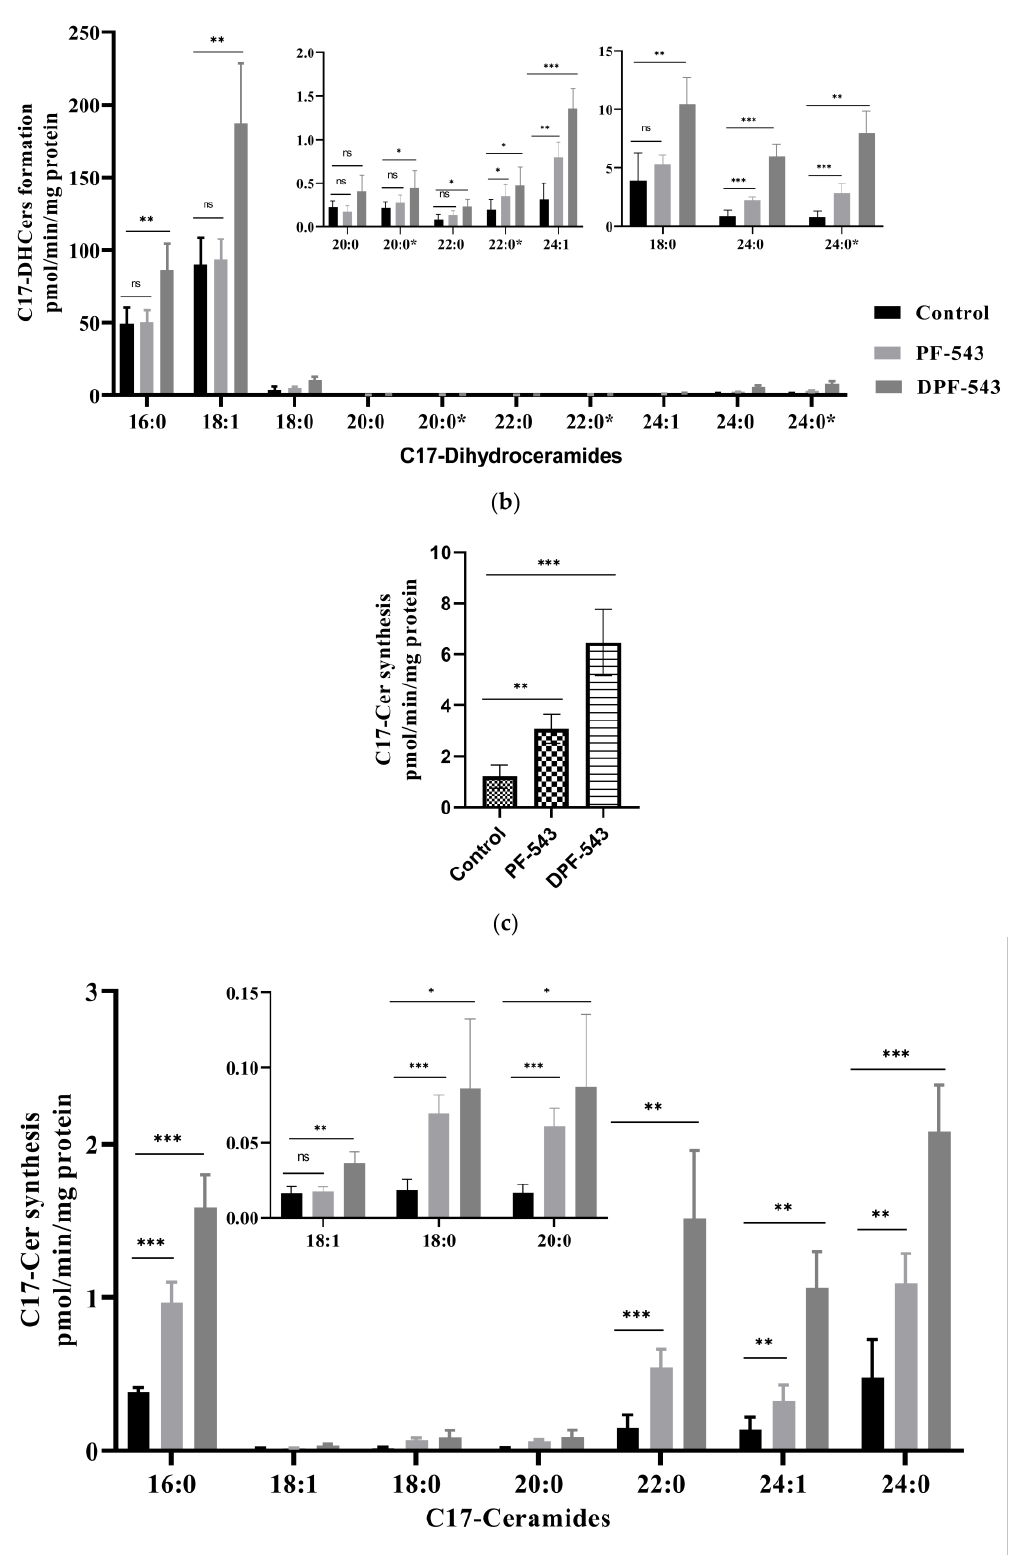
Figure 4. ( a ) Total C17-DHCer amount in PF-543 and DPF-543 application; ( b ) individual C17-DHCer accumulation by PF-543 and DPF-543 treatment; ( c ) total C17-Cer amount in PF-543 and DPF-543 application; ( d ) individual C17-Cer alteration by PF-543 and DPF-543. Data are shown as means ± SD, ns—not significant, * p < 0.05, ** p < 0.01, *** p < 0.001.